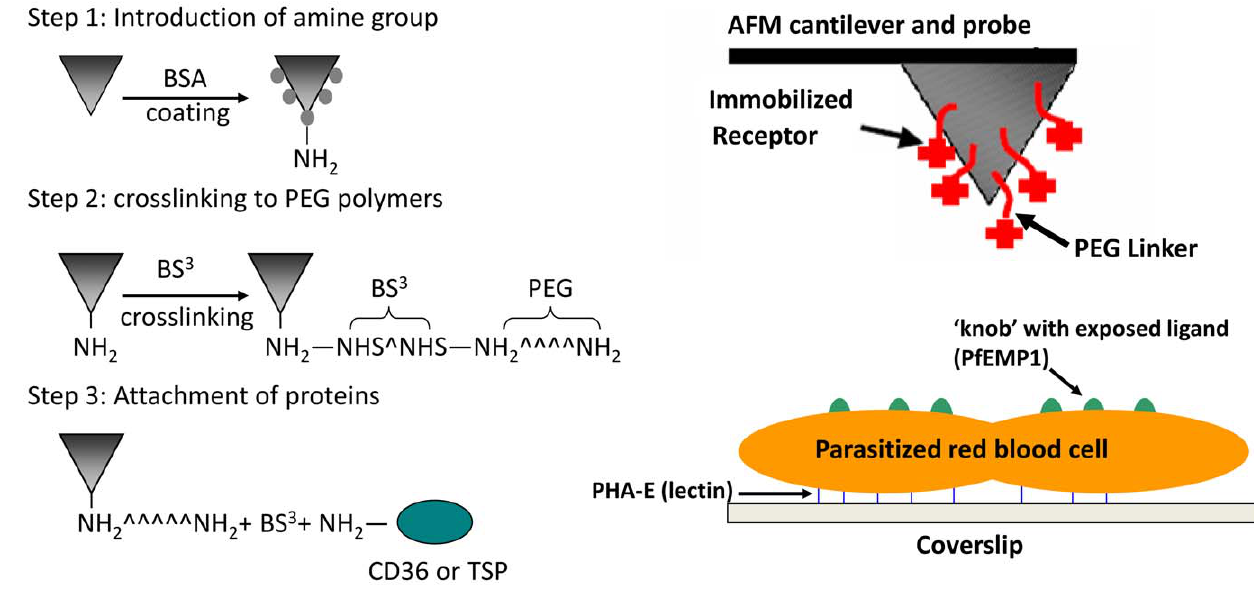
Figure 1. Schematic illustration of AFM tip functionalization chemistry and experimental configurations.